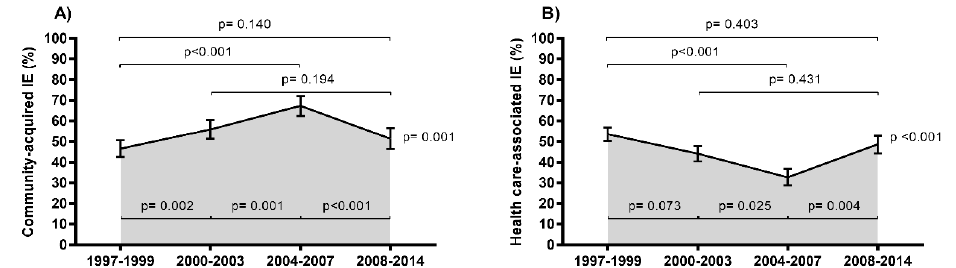
Figure 4. Epidemiological trends of infective endocarditis (IE) in HIV-infected patients in Spain (1997 Table 2014 stratified by modes of acquisition. ( A ) Community-acquired IE. ( B ) Health care-associated IE. Statistical: Di ff erences between groups were calculated by the Chi Square test. Linear trends